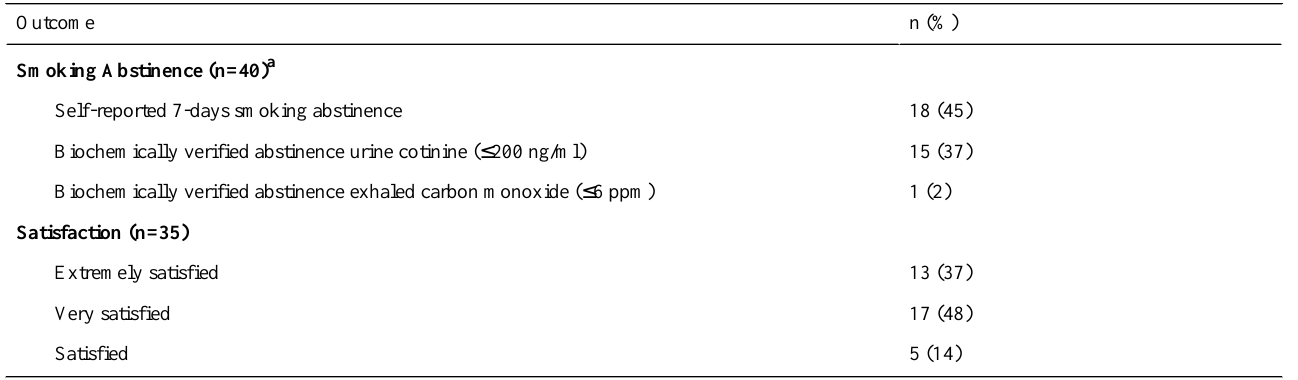
Table 3. The 3-month follow-up